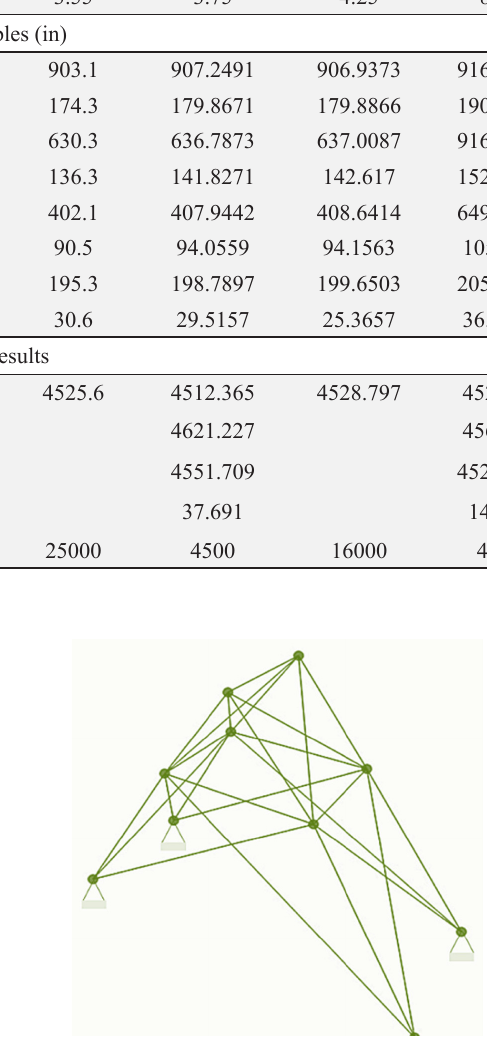
Fig. 9. Optimal layout for the spatial 25-bar truss